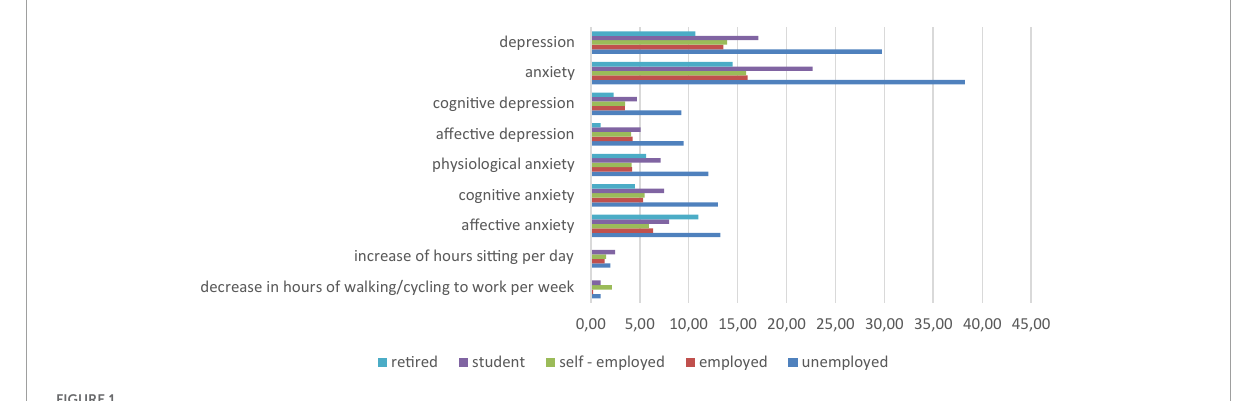
FIGURE1 Significant differences in participants with different employment statuses in changes in physical activity (PA) during epidemic and anxiety and depression.